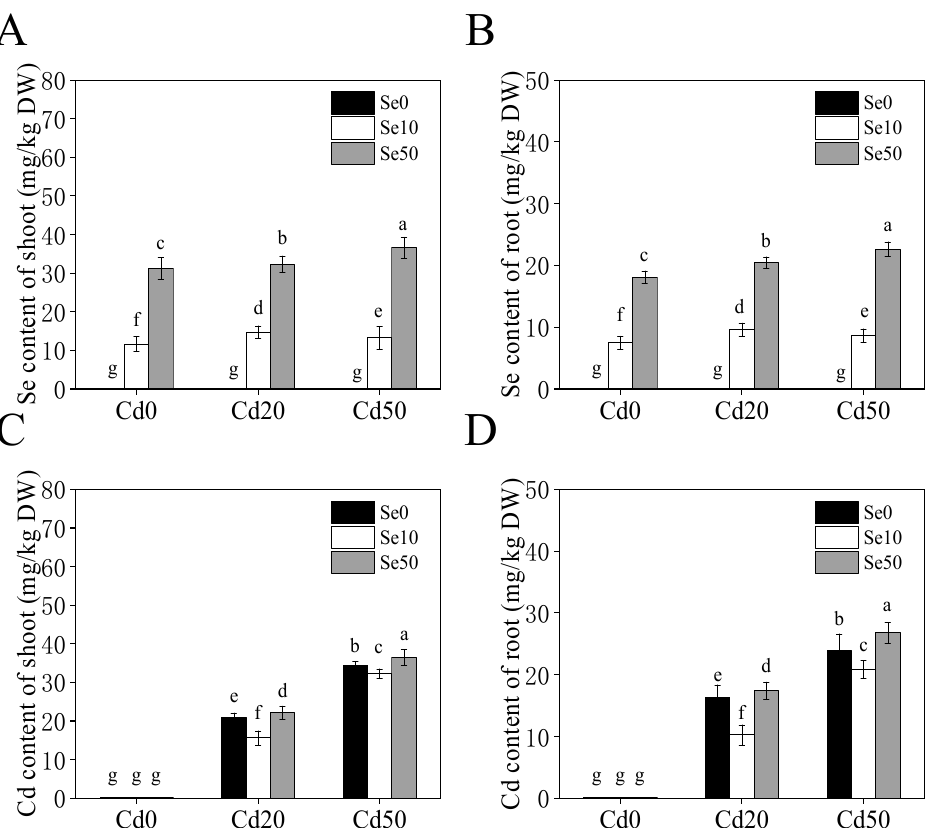
Figure 3. Content of Se and Cd in tobacco under different Se and Cd concentration supply conditions for 21 days. ( A , B ) Se content of the shoots and roots under different Se ( Ⅳ ) and Cd ( Ⅱ ) concentration supply conditions; ( C , D ) Cd content of the shoots and roots under different Se ( Ⅳ ) and Cd ( Ⅱ ) concentration supply conditions. 14-days-old seedlings (wild-type, Yunyan 87) were grown in pot with sand under different Se (0, 10, 50 μ M) and Cd (0, 20, 50 μ M) concentration for 21 days. Se0 : no Se; Se10 : Se, 10 μ M; Se50 : Se, 50 μ M; Cd0 : no Cd; Cd20 : Cd, 20 μ M; Cd50 : Cd, 50 μ M. Shown are mean ± SD from five biological replicates. Different letters indicate significant differences ( p < 0.05).